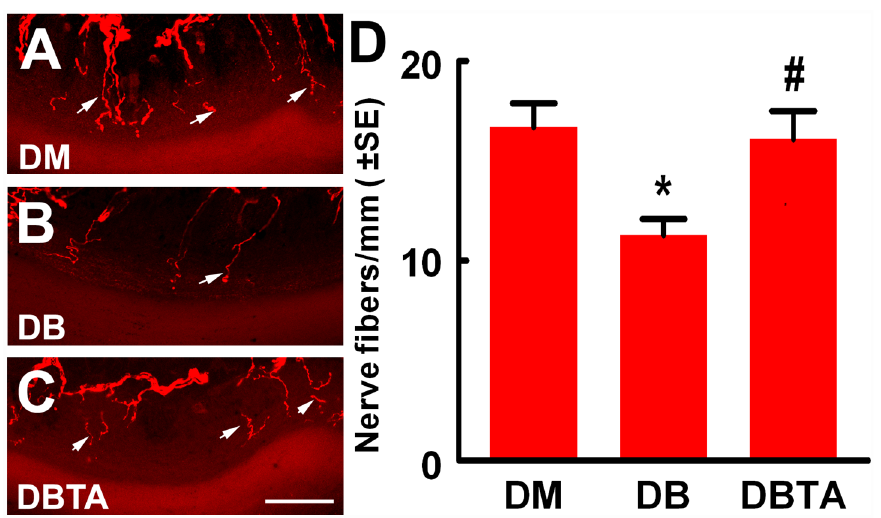
Fig 4. Tadalafil increases intraepidermal nerve fiber density in diabetic db/db mice. Panels A to C show PGP 9.5 immunoreactive intraepidermal nerve fibers (red, arrows) in the plantar skin from a representative non-diabetic mouse treated with saline (DM, A), diabetic mouse treated with saline (DB, B) and diabetic mouse treated with tadalafil (DBTA, C). Panel D shows quantitative data. * p < 0.05 and #p < 0.05 versus the non-diabetic mouse (DM) and the diabetic mouse treated with saline (DB), respectively. n = 10/group. Bar = 50 μ m. DBTA = diabetic mouse treated with tadalafil.